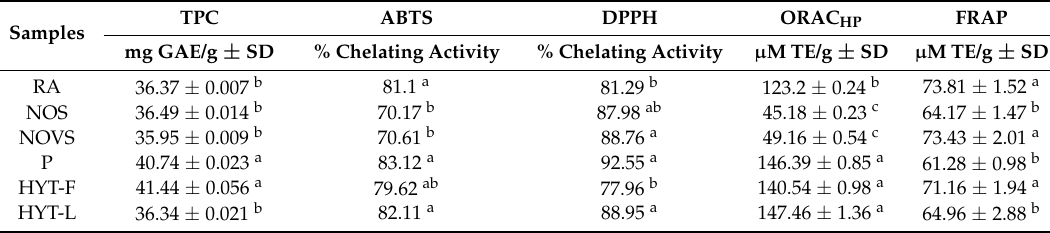
Table 2. Total phenolic content (TPC) of natural extracts (mg GAE/g) and their antioxidant activity by measuring their ABTS, and DPPH radical scavenging activity, together to their ORAC HP , and FRAP ( µ M